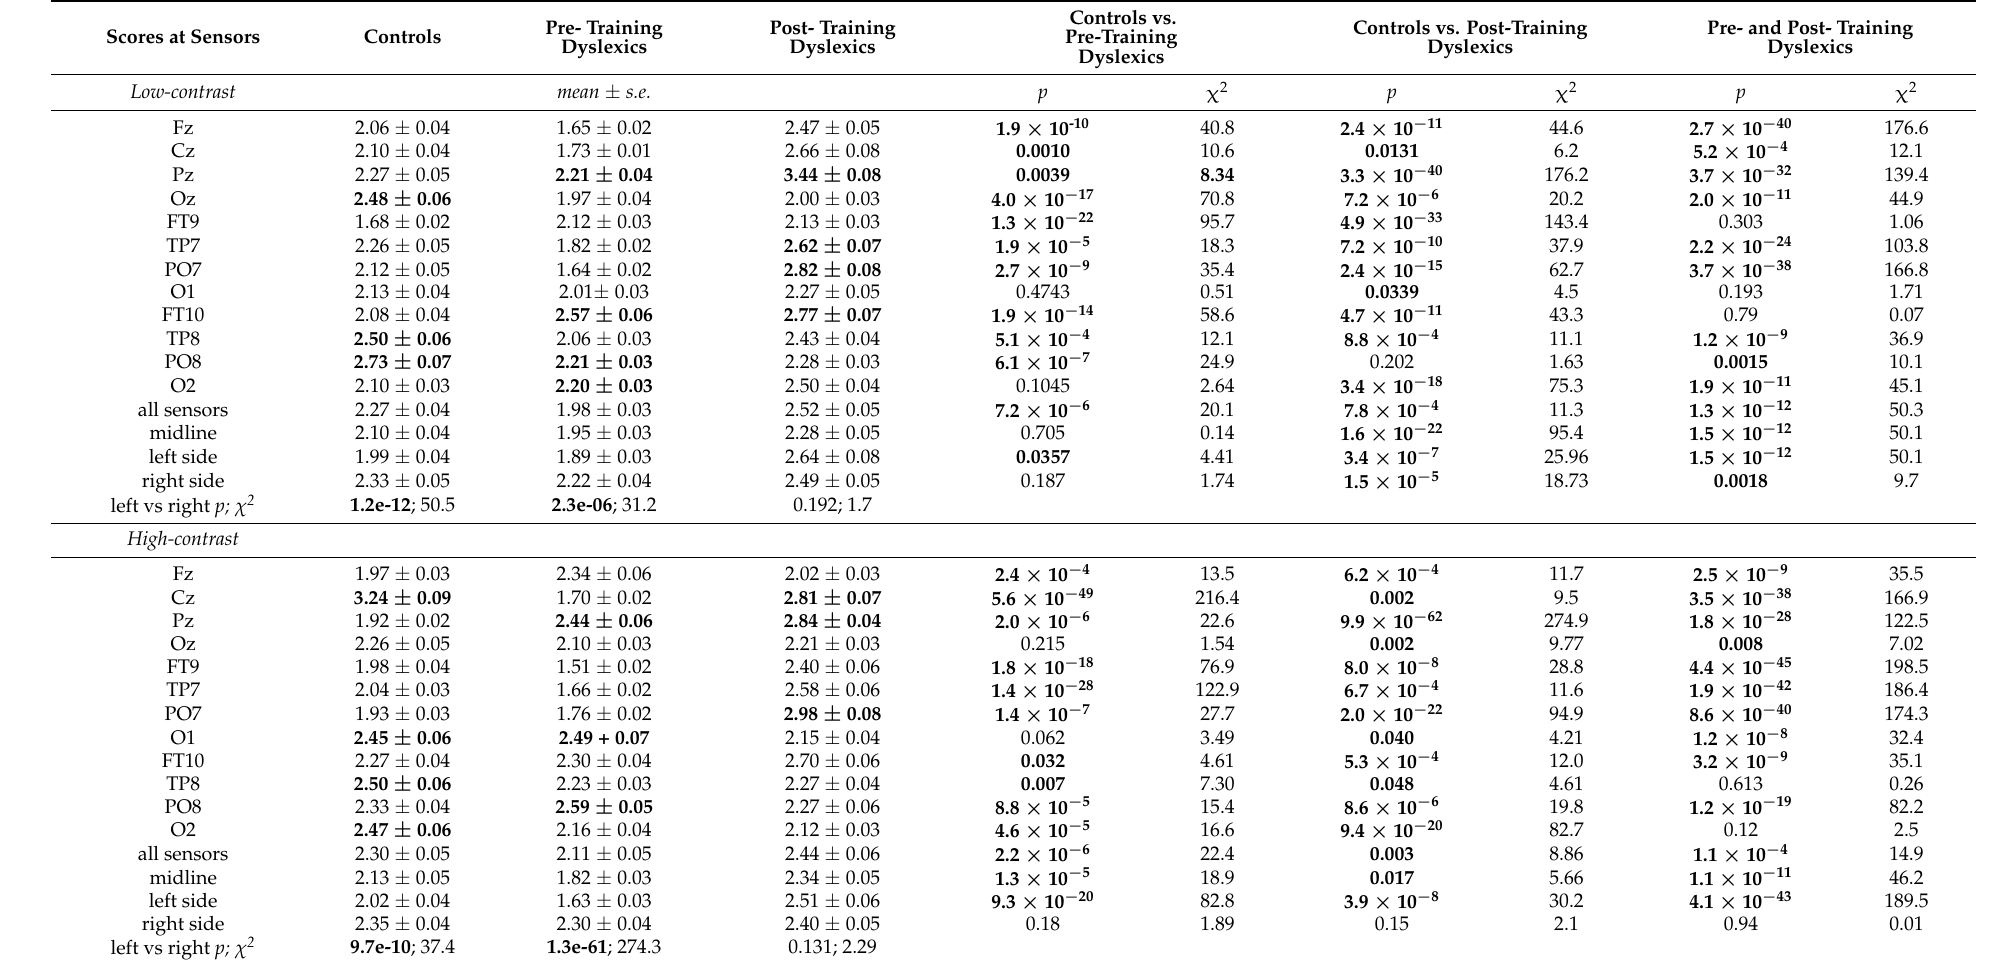
Table 4. Statistics of α / θ scores between sensors of the groups for qEEG z-NF trainings ( p < 0.05).